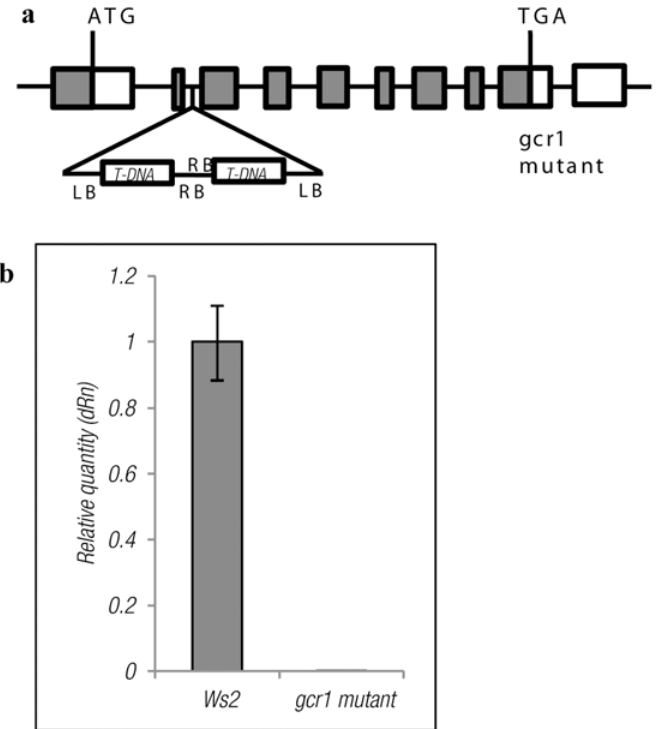
Fig 1. (a) T-DNA insertion site/orientation in the mutated gene of GCR1. The exons are represented as boxes and the introns are represented as lines. LB and RB represent the left and right border respectively. (b) qPCR validation of the mutant. The real time RT-PCR was performed in triplicate using independent samples of total RNA and the values are represented as relative quantity ±